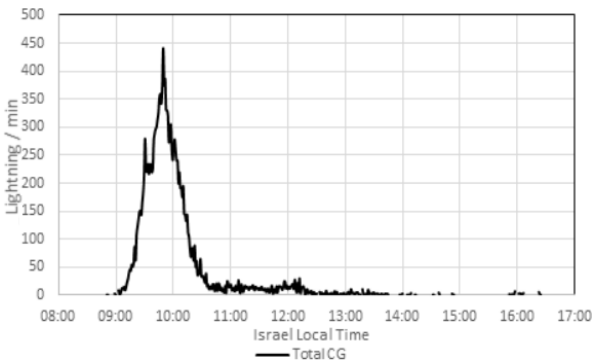
Figure 4. One-minute accumulated lightning numbers detected on 25 October 2015 as a function of time. The total CG strike rate (grey) exhibits a sharp maximum around 09:45LT, as the cells passed over central